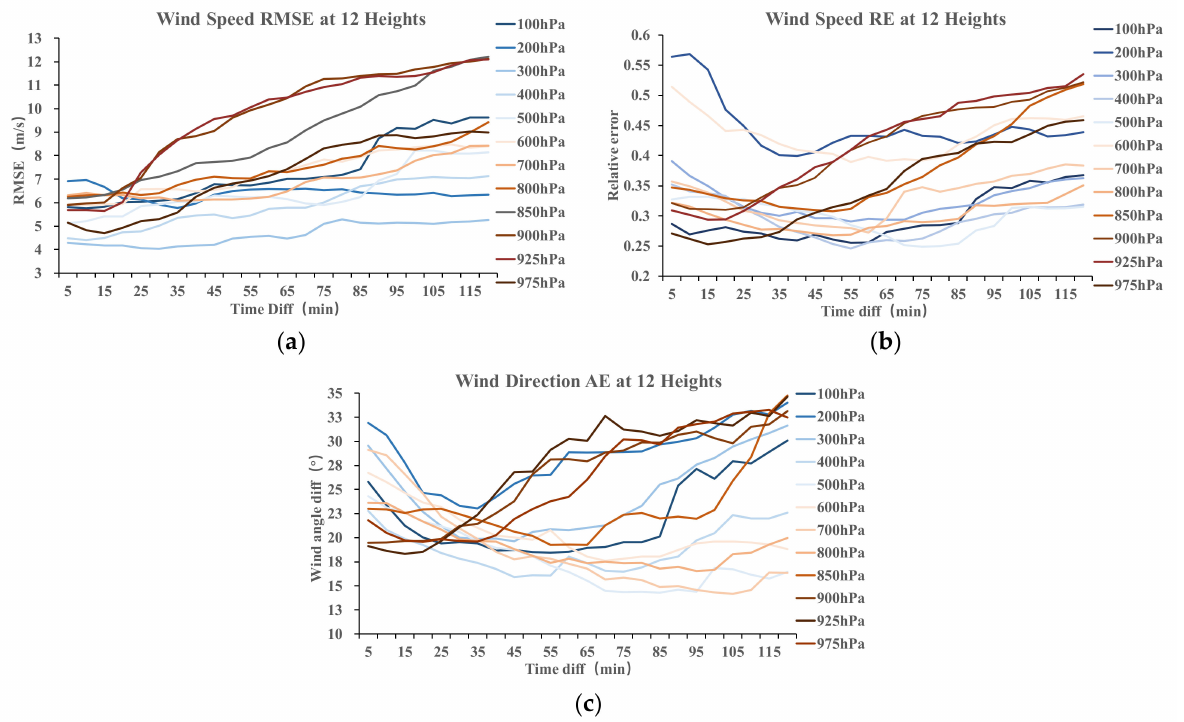
Figure 7. The wind speed RE ( a ), wind speed RMSE ( b ), and wind direction AE ( c ) between WRF wind fields and Farneback OF wind fields of different satellite revisiting times at 12 heights.